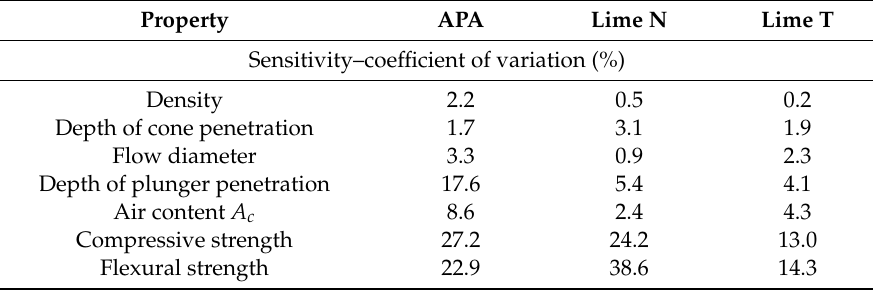
Table 7. The sensitivity of properties of plaster to changing cement Table 6. Results of tests of the influence of cement type on properties of masonry mortars.